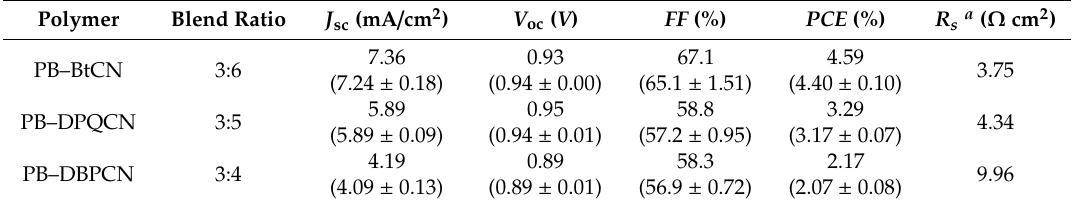
Figure 5. ( a ) Current density–voltage ( J – V ) curves of the PSCs and ( b ) the IPCE spectra of the PSCs based on PB–BtCN, PB–DPQCN, and PB–DBPCN. Table 2. Best photovoltaic parameters of the devices based on the polymer. The averages of the photovoltaic parameters of each device are shown in parentheses.